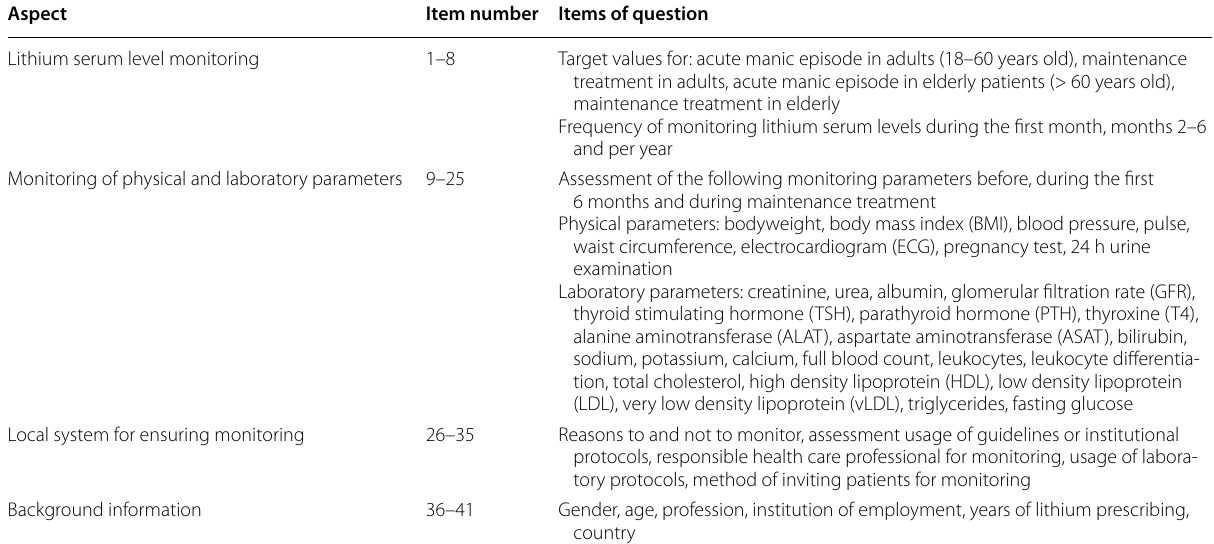
Table 1 Aspects covered in the questionnaire on monitoring of patients using lithium